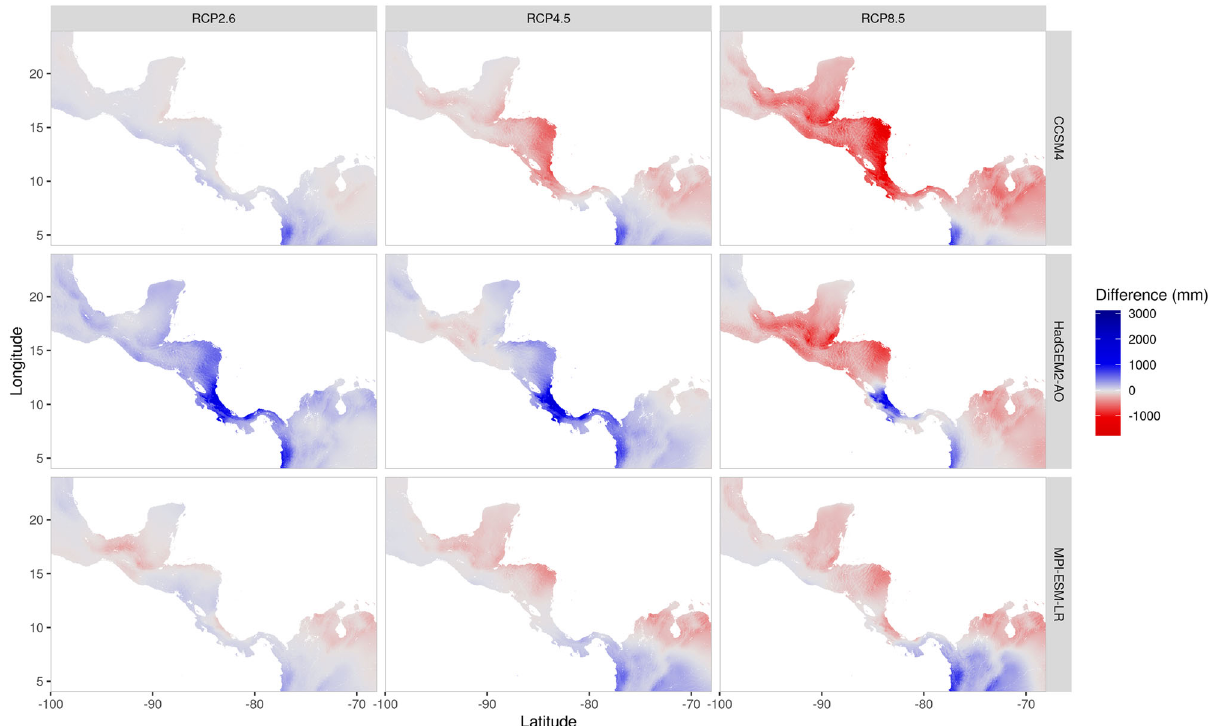
Fig. 4 Precipitation change. Difference of annual precipitation sum between present-day and climate projections (2061 – 2080).